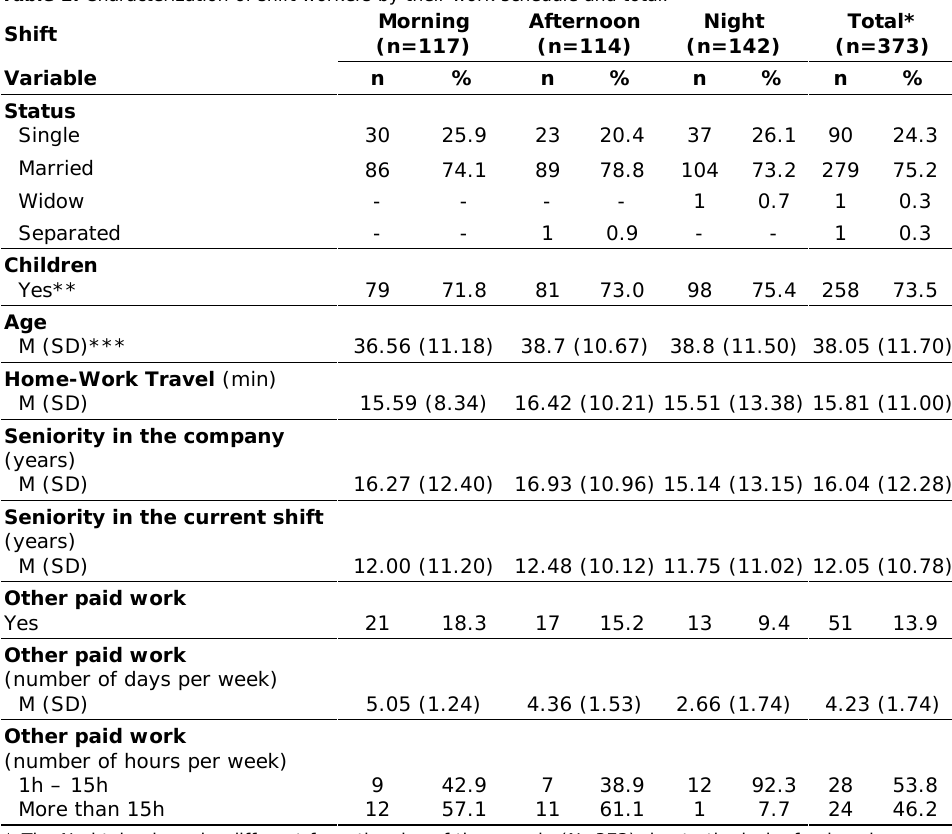
Table 1. Characterization of shift workers by their work schedule and